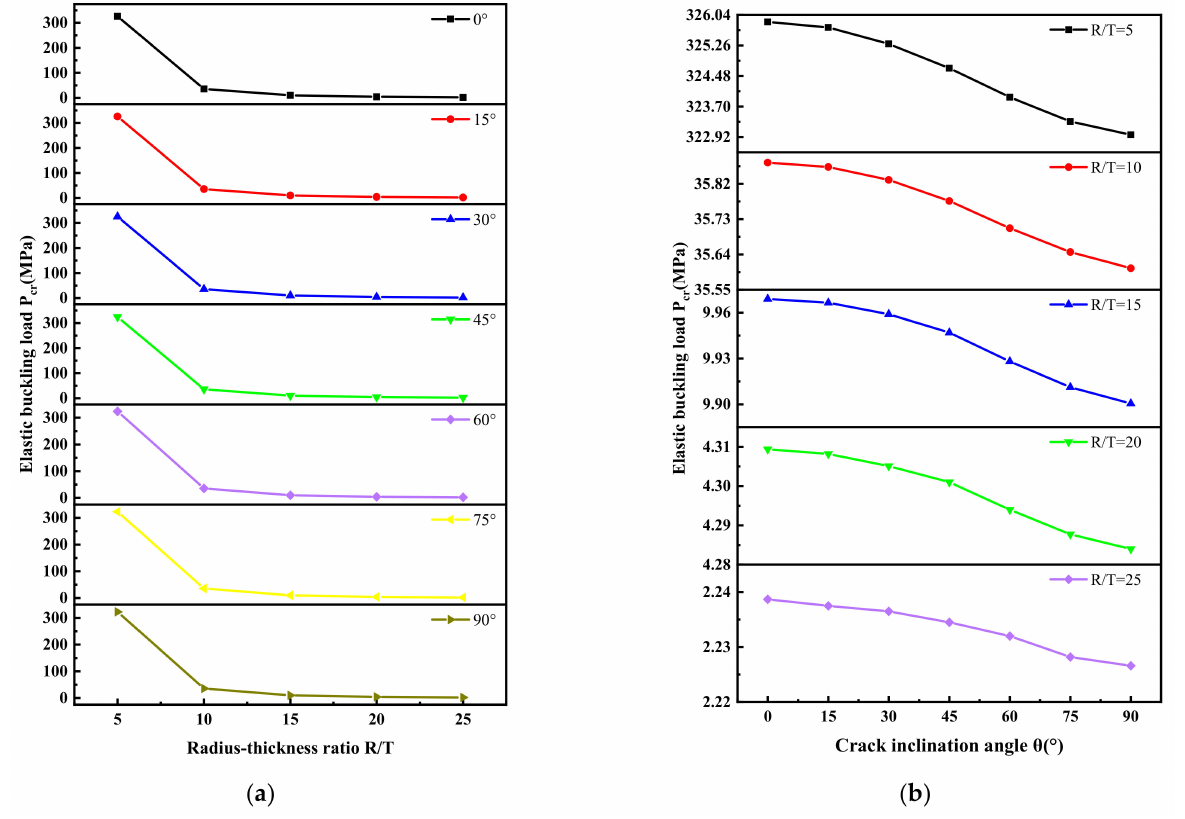
Figure 7. Relation between radius-thickness ratio and elastic buckling load ( a ) Different radius-thickness ratios; ( b ) Different crack inclination